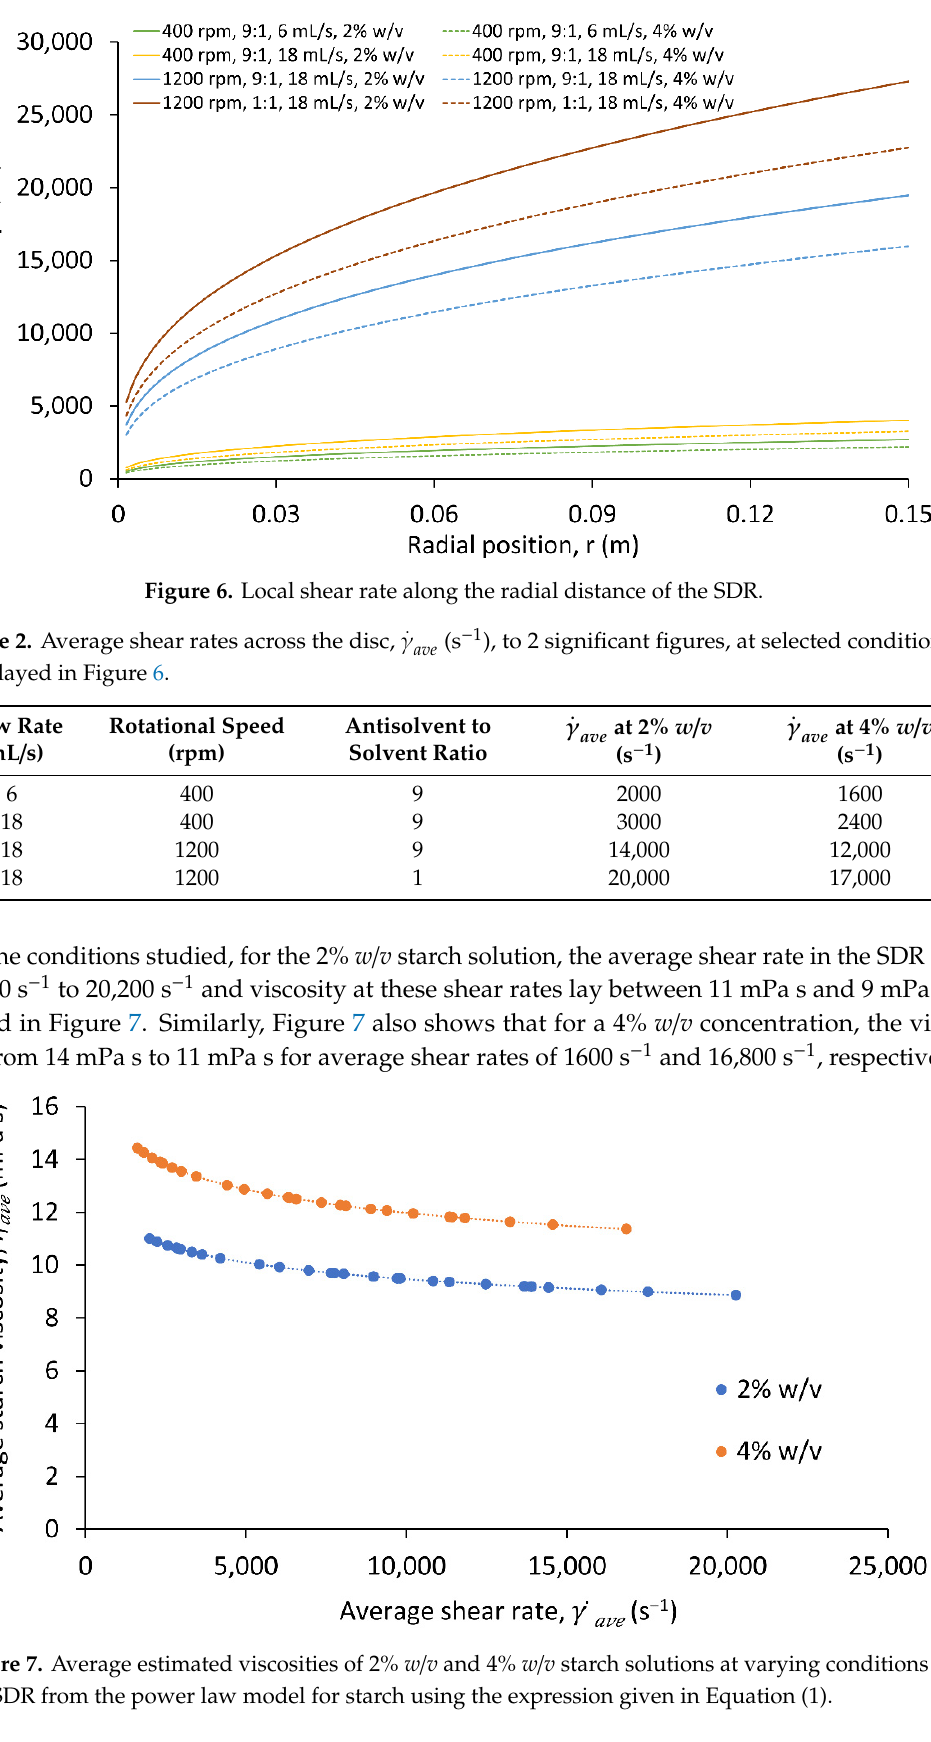
Figure 8. Effect of disc rotational speed on shear rate at various experimental conditions.